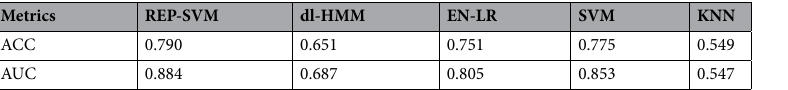
Table 2. ACC and AUC comparison using all patients’ data in Dataset1, where the training set contains 27 patients with seven time points and testing set consists of the remaining 26 patients with less than seven time points. Percentage of missing values in the training set is 0.23% and that in the testing set is